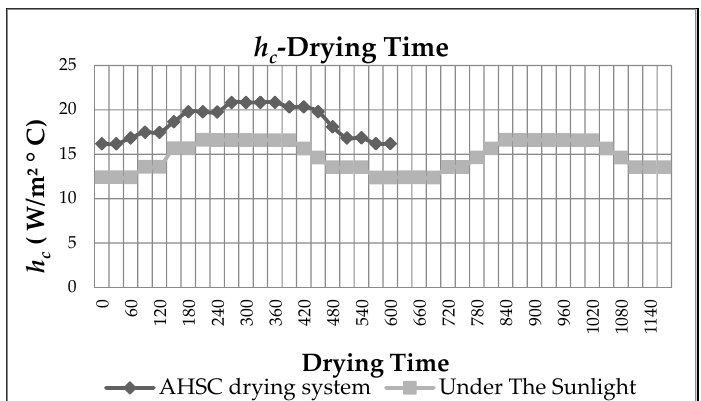
Figure 8. h c changing with drying time.